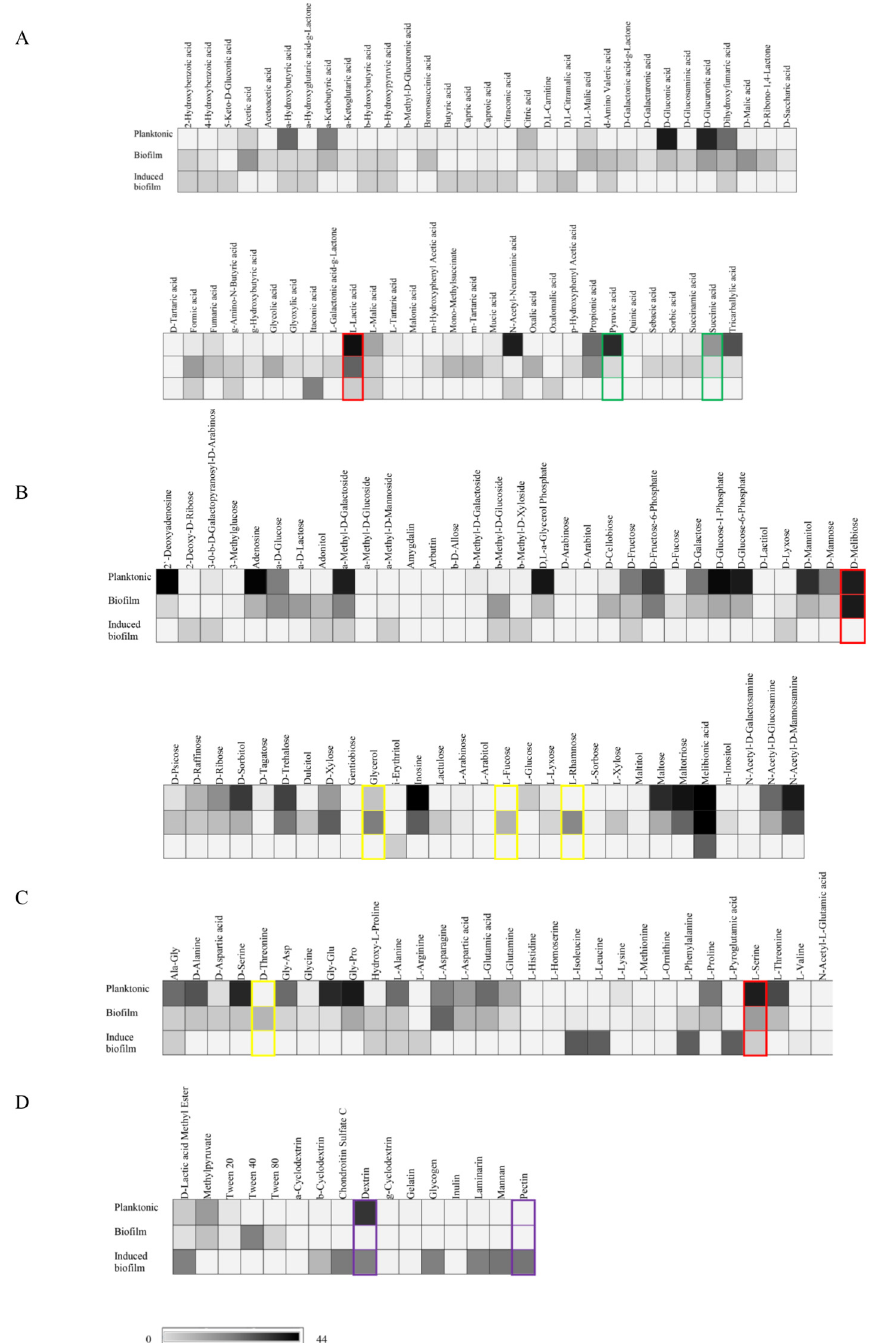
Fig 2. Carbon substrates utilized by S . Typhi human carrier strain, CR0044. Fig 2A. Carboxylic acid; Fig 2B. Carbohydrate; Fig 2C. Amino acid; Fig 2D. Ester, fatty acid and polymer. Area under the growth curve values of substrates utilized by S . Typhi strain CR0044 was determined using Biolog Phenotype MicroArray plates PM1 and PM2. The maximal kinetic curve height was expressed as a grayscale ranging from 0 (light gray) to 44 (black) area under the curve units. Color highlights show differences between biofilm and planktonic S . Typhi; green (planktonic only), yellow (biofilm only), red (both planktonic and biofilm), purple (induced biofilm). Phenotypes < 0 were considered